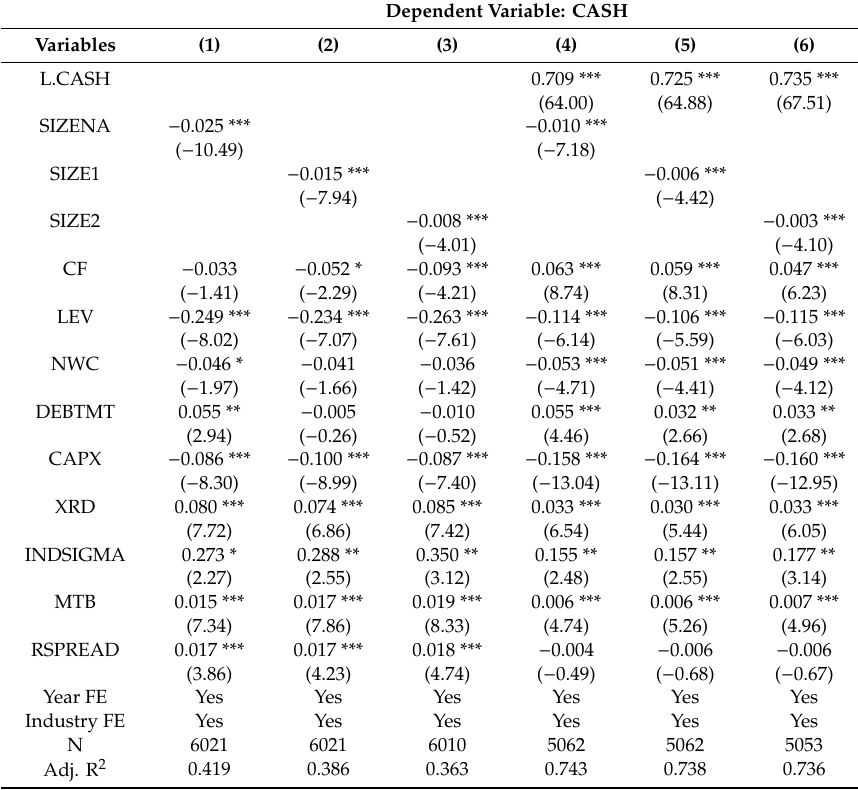
Table 12. Alternative measures of firm